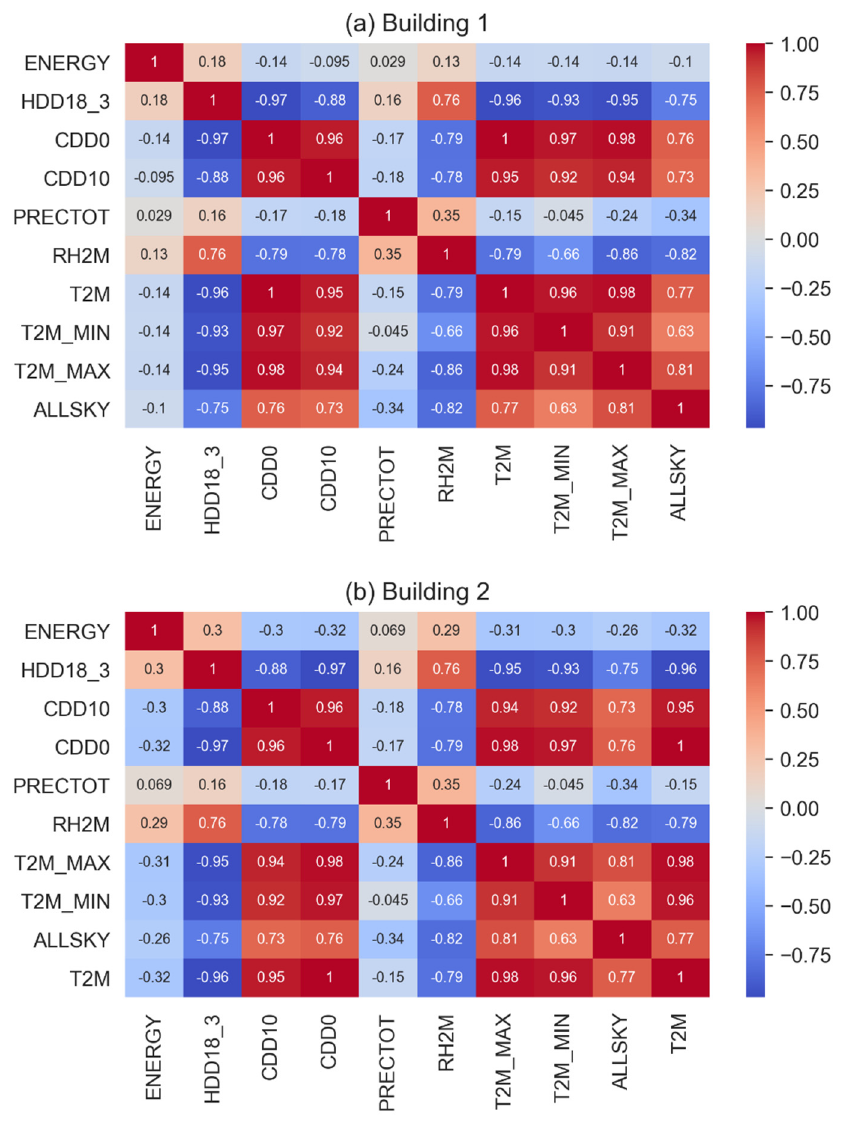
Figure 2. ( a ) Correlation heatmap between climatic variables for building 1; ( b ) correlation heatmap between climatic variables for building 2.